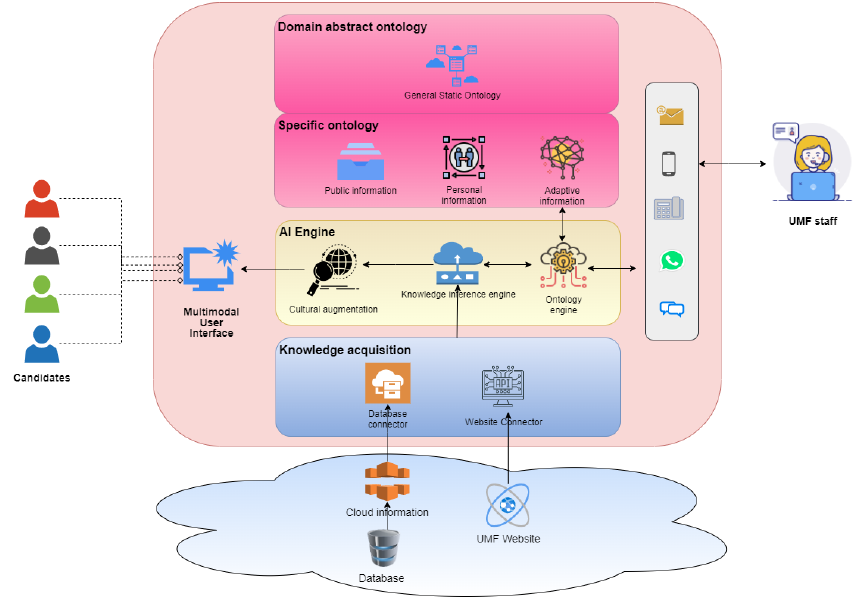
Figure 2. Ana Chatbot Architecture.